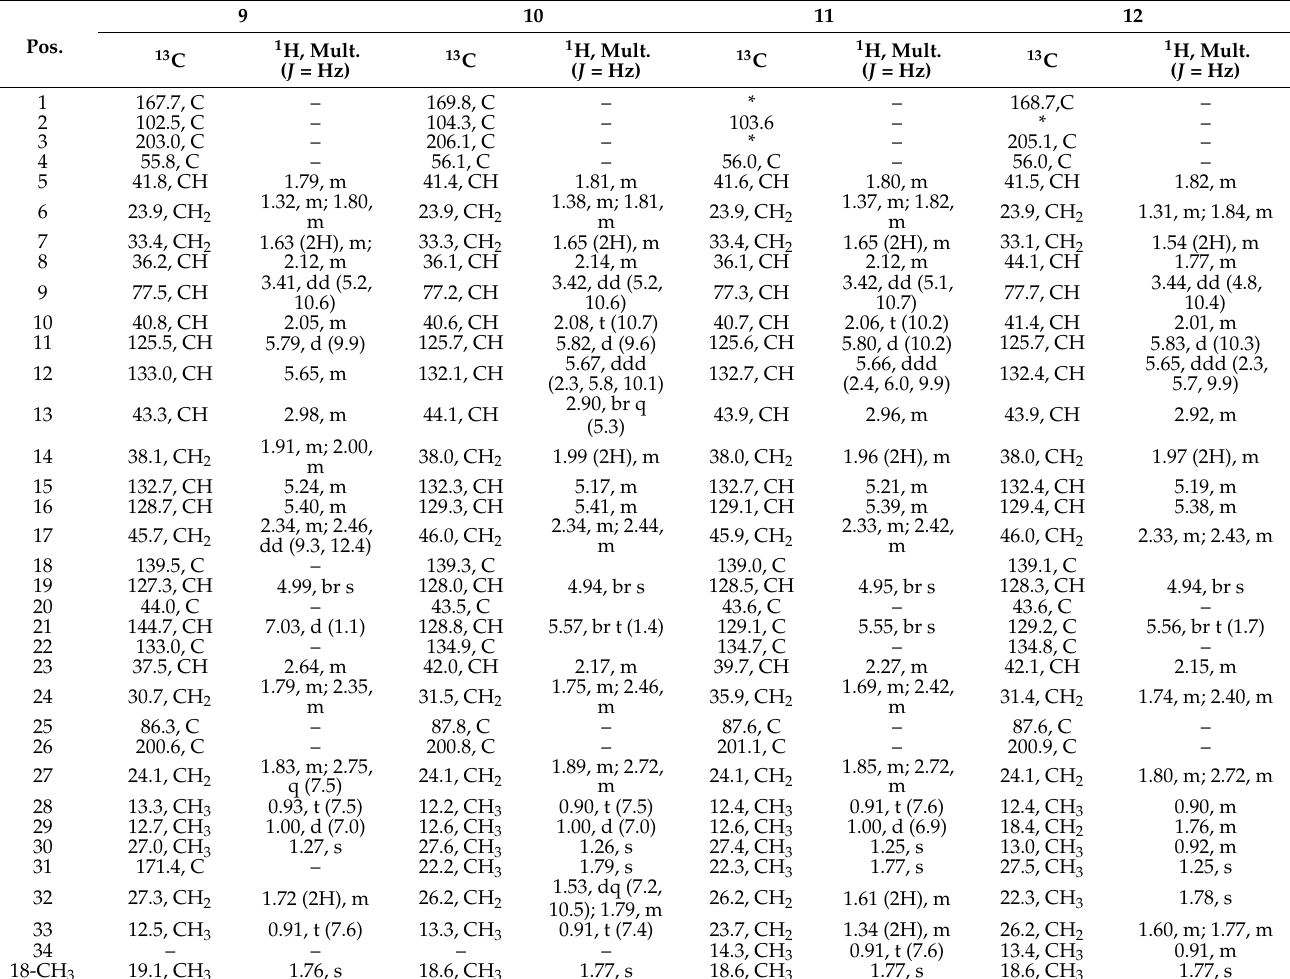
Table 2. 1 H (400 MHz) and 13 C (100 MHz) NMR data of decatromicins D– G ( 9–12 ) in MeOH- d 4